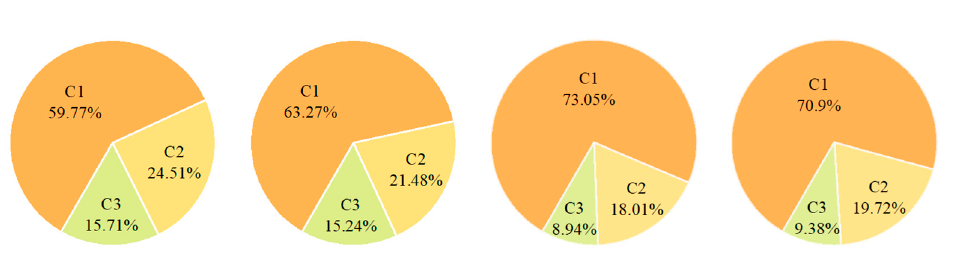
Figure 2. ( a ) Three fluorescent components (C1, C2, and C3) identified by the EEM; ( b ) The relationship between the fluorescence intensity and wavelength of the excitation (Ex) and emission (Em) wavelengths of each fluorescent component.